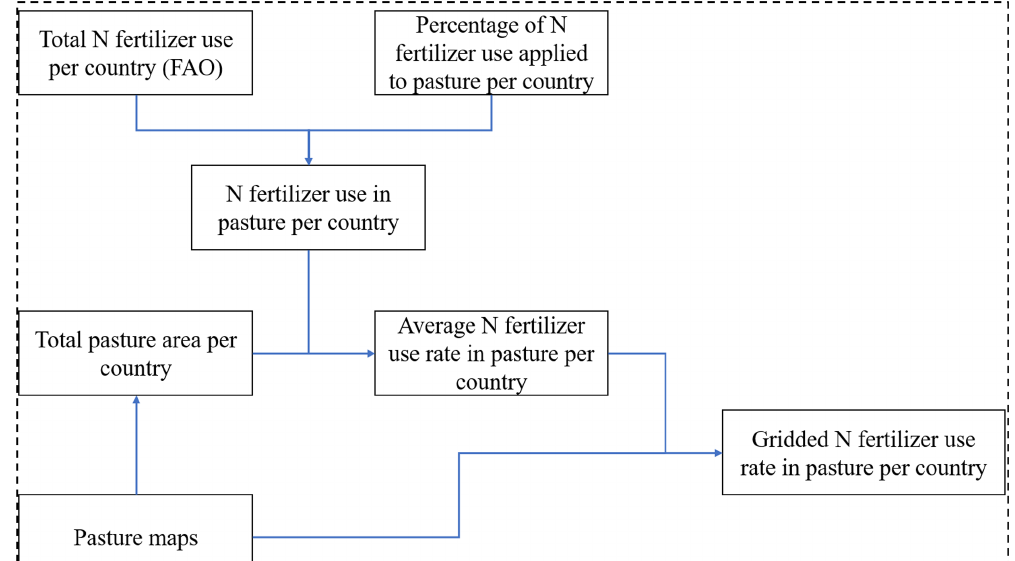
on buffaloes, cattle, chickens, ducks, horses, goats, pigs,